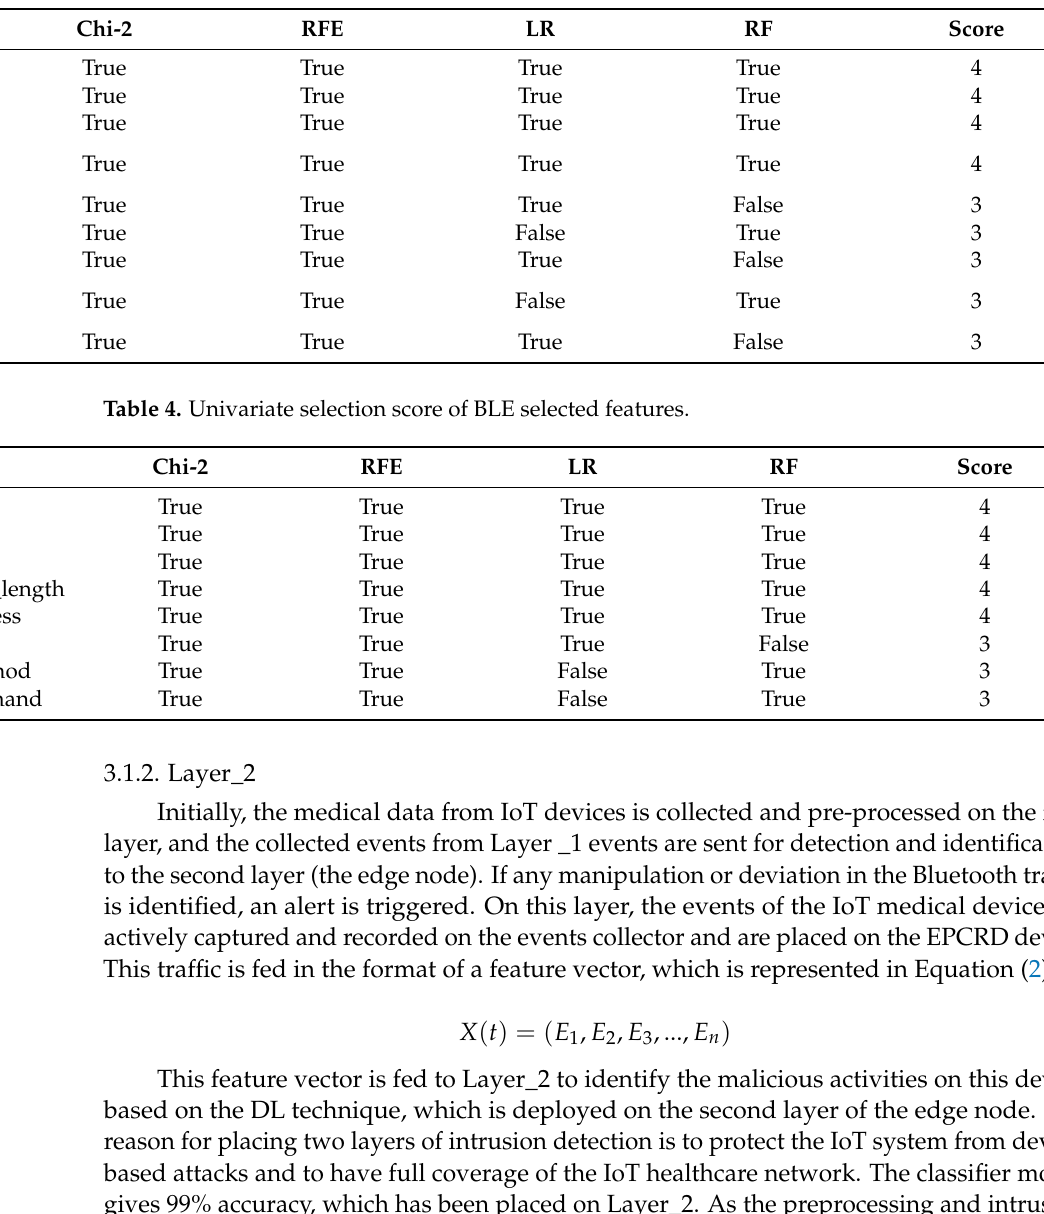
Table 3. Univariate selection score of the BR/EDR selected feature.